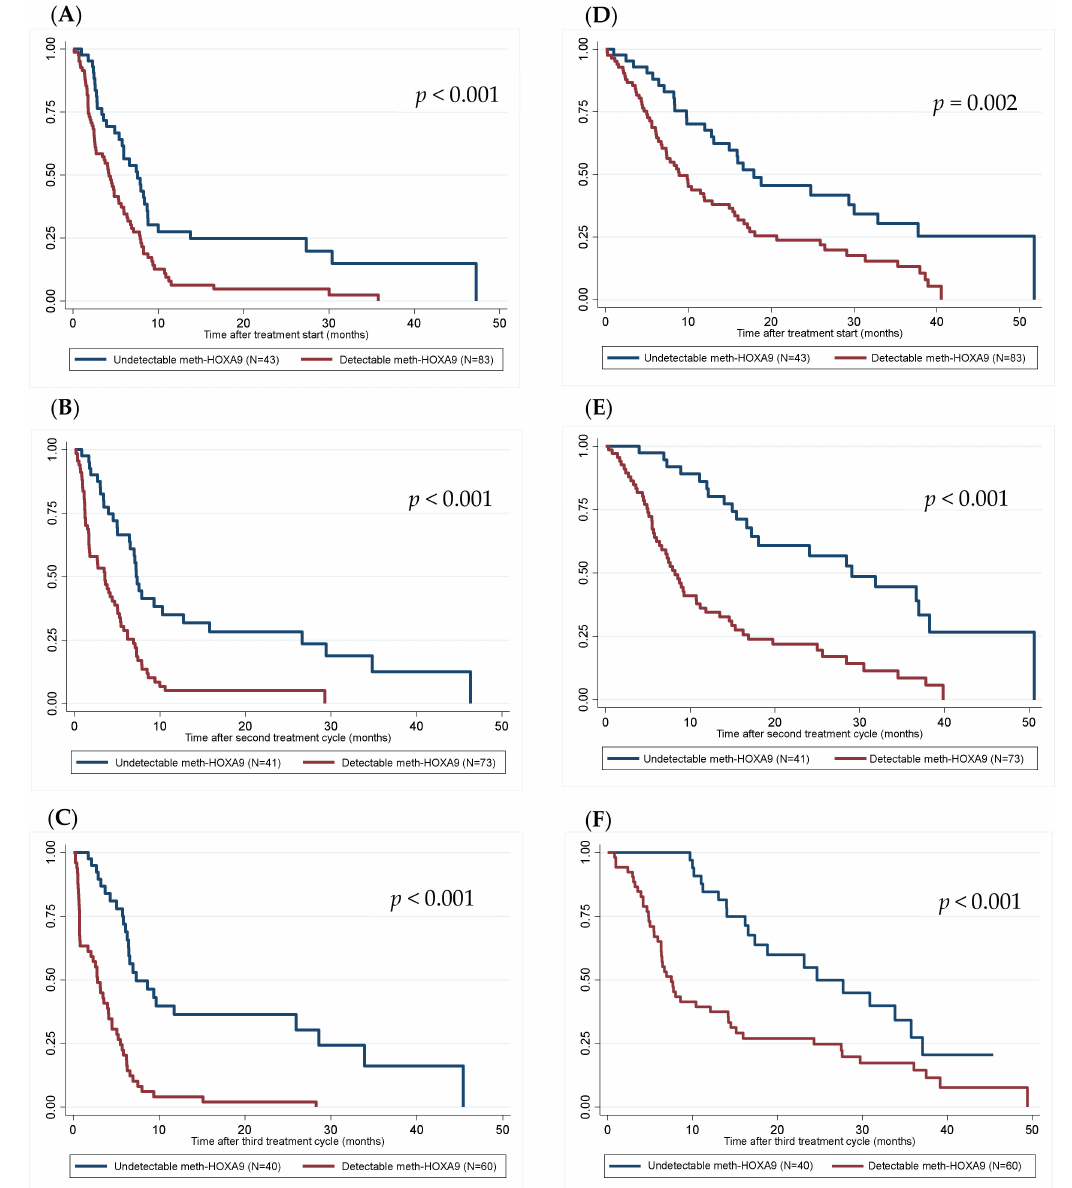
Figure 1. Kaplan-Meier plots for detectable vs. undetectable meth- HOXA9 at baseline (( A )—PFS at baseline, ( D )—OS at baseline), at second treatment cycle (( B )—PFS at second treatment cycle, ( E )—OS at second treatment cycle), and at first evaluation after three treatment cycles (( C )—PFS after three treatment cycles, ( F )—OS after three treatment cycles) for progression-free survival ( A – C ) and overall survival ( D – F )